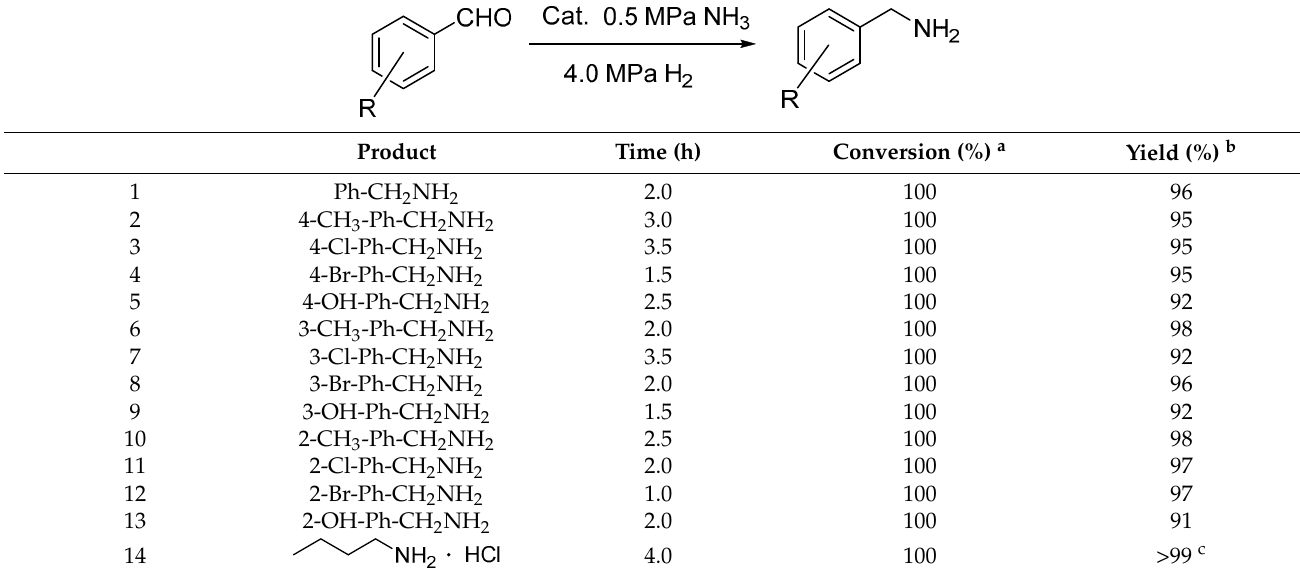
Reaction conditions: 5.0 mmol aldehyde, 50 mg Ni 12.4 -30 catalyst (about 2.0 mol% Ni), 0.5 MPa NH 3 and 4.0 MPa H 2 , 20 mL of isopropanol, 120 °C. a Calculated by GC. b Isolated yield. c GC yield.